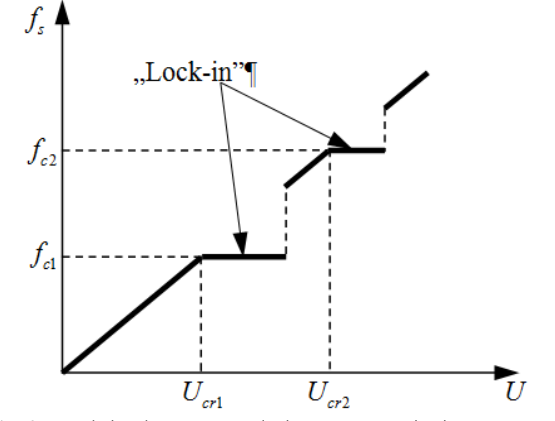
Fig. 2. Lock-in phenomenon during vortex excitation.